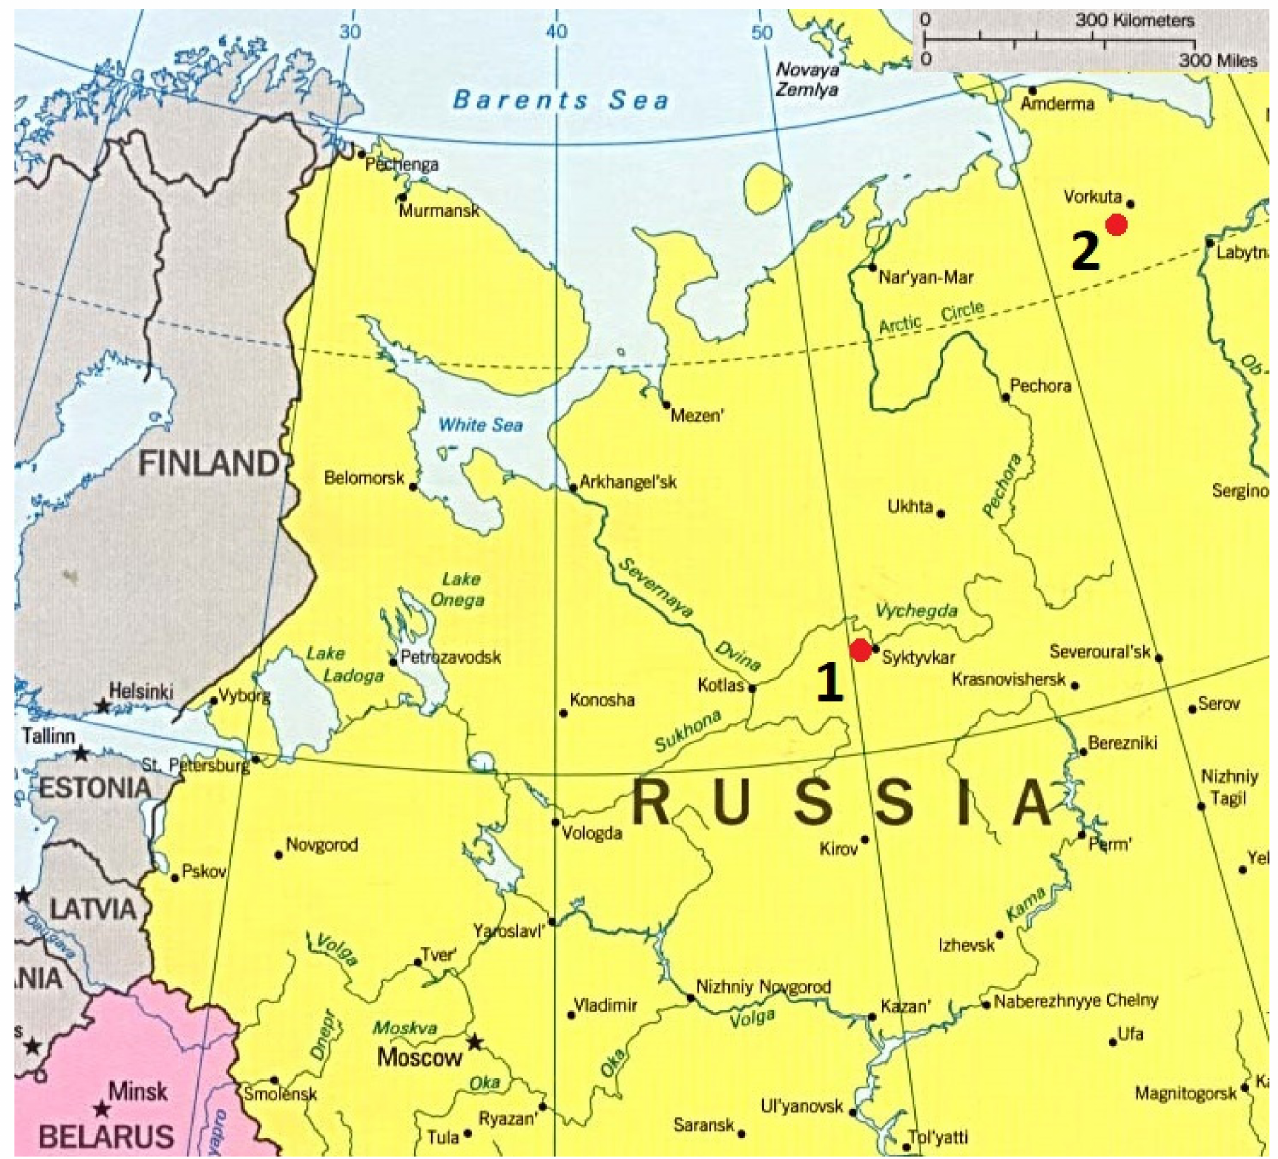
Figure 1. Locations of the sampling points of the taiga (1), and the tundra (2)